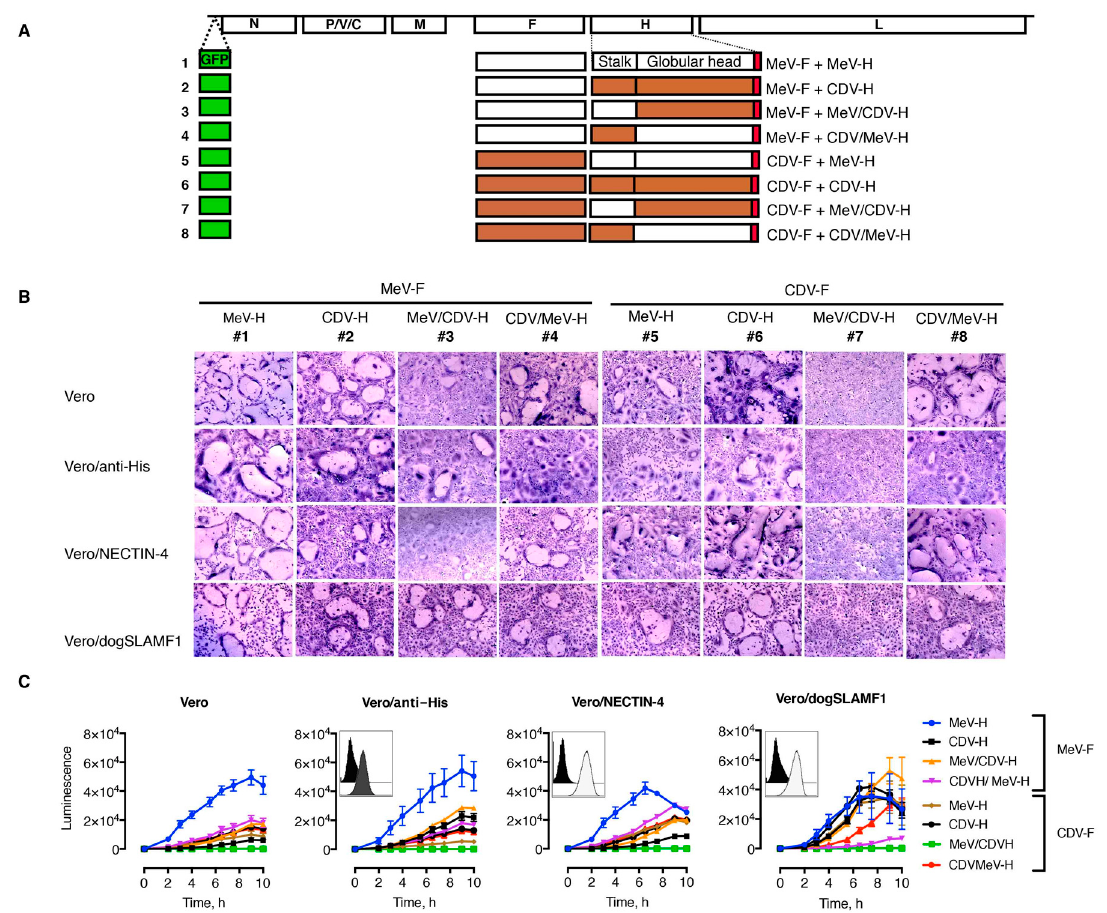
Figure 2. Functional analysis of hybrids construct and heterotypic complementation. ( A ) Schematic representation of the morbillivirus genome organization. Open boxes represent the open reading frames: nucleocapsid (N), phospho- (P), matrix (M), fusion (F), hemagglutinin (H), and large (L). V and C are accessory proteins transcribed from the P gene. Combinations of H and F proteins were cotransfected for functional assays and incorporated afterward into the MeV genome. Combinations and virus numbers denote the combination of the envelope glycoproteins used. ( B ) Syncytium formation assay. These representative microphotographs were taken at 24 h after transfection of cells with plasmid DNA encoding various H and F protein combinations. Scale bar represents 100 µ m. ( C ) Quantitative fusion assay. Expi293F cells (e ff ector cells) were transfected with the di ff erent plasmids encoding H and F plus one part of the dual-split reporter plasmid (DSP). After cocultivation with Vero cells carrying the second DSP half, the luminescence signal was recorded over time. Values and error bars (SDs) are from one representative experiment performed in triplicate. Insert indicates surface expression of